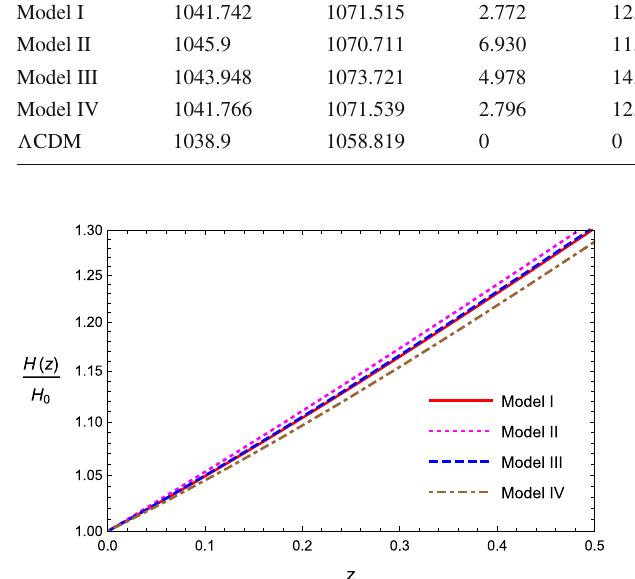
Fig. 3 It represents the dimensionless H ( z )/ H 0 vs z plot